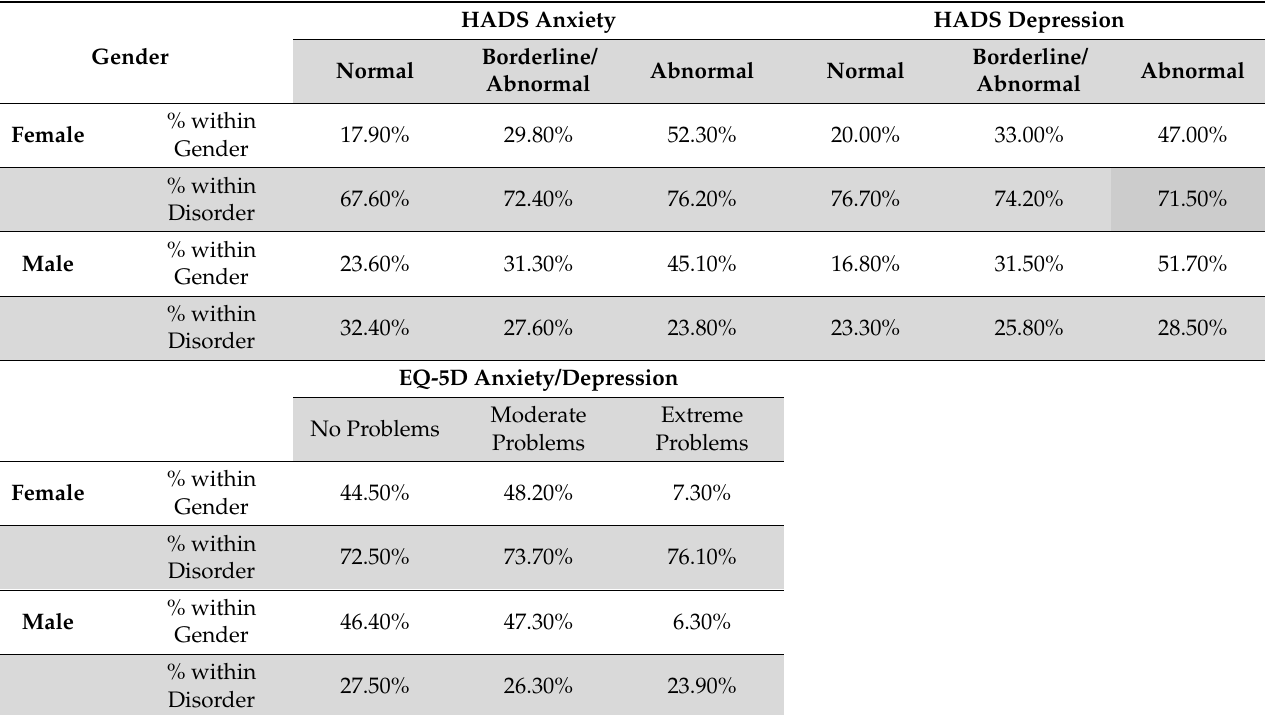
Table 4. Statistics showing anxiety and depression frequencies according to